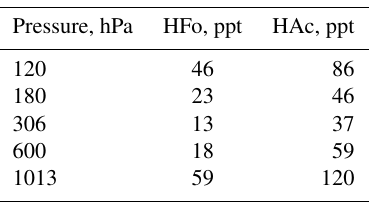
Table 2. Laboratory detection limits (ppt) determined as 3 times the SD of the blank using a pure air system as a function of sample inlet pressure